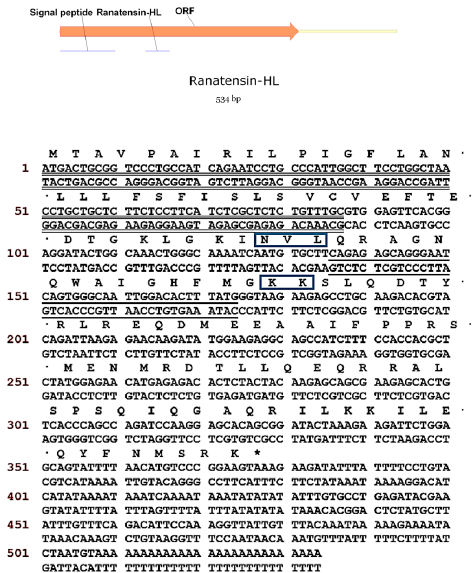
Figure 4. Nucleotide and open-reading frame translated amino acid sequences of cloned cDNA encoding the biosynthetic precursor of ranatensin-HL. The putative signal peptide is double-underlined, the mature peptide sequence is single-underlined and the stop codon is indicated by an asterisk. The proteolytic cleavage sites for the mature peptide are boxed.